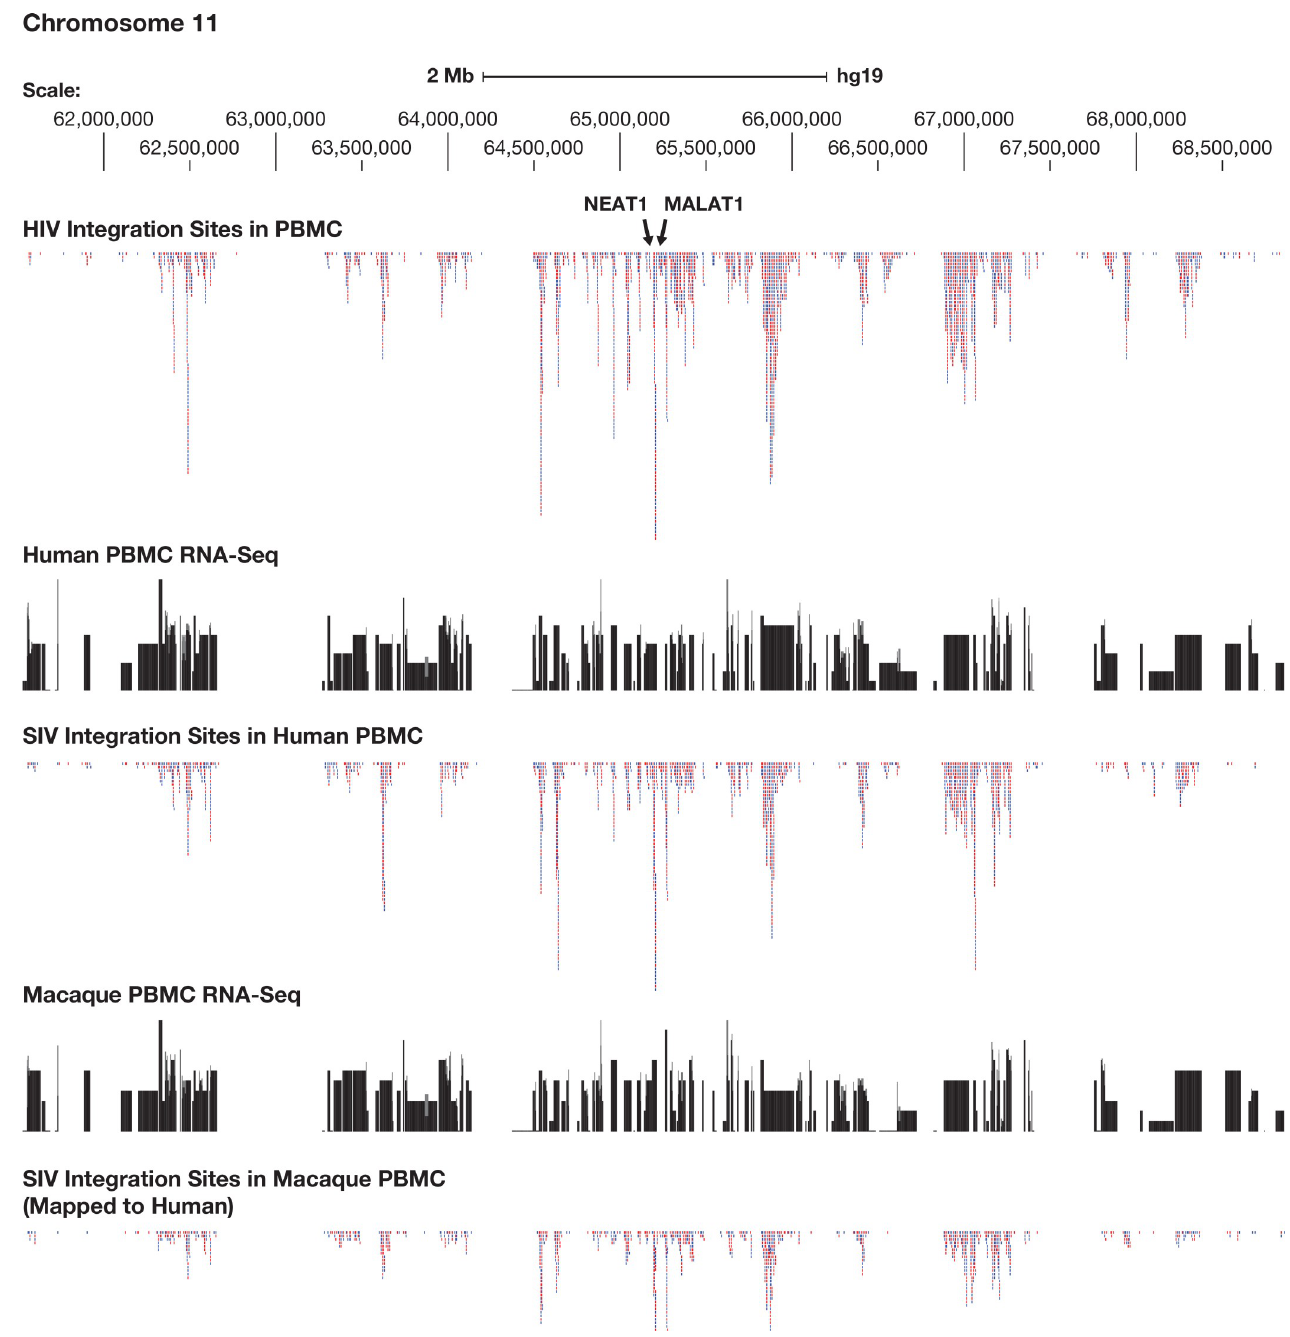
Fig 4. SIV and HIV preferentially integrate into regions that contain highly expressed genes. The figure shows a region of human chromosome 11 approximately 6 megabases in length that is centered around the long noncoding gene NEAT1. The top panel shows the distribution of 100,000 HIV integration sites in human PBMC, chosen at random from the 385,000 member library we prepared (reducing the number of HIV/human PBMC integration sites makes it easier to compare the data). The proviruses that are inserted in the same orientation as the numbering of the chromosome are shown in red, those in blue are in the opposite orientation. The second panel shows the human PBMC RNA-Seq data, mapped to the human genome, on a log scale. The third panel shows the distribution of SIV integration sites in human PBMC. The fourth panel shows RNA-Seq data from the macaque PMBCs, mapped to the human genome, and plotted on a log scale. The bottom panel shows the distribution of SIV integration sites in macaque PBMCs, mapped onto the human genome.